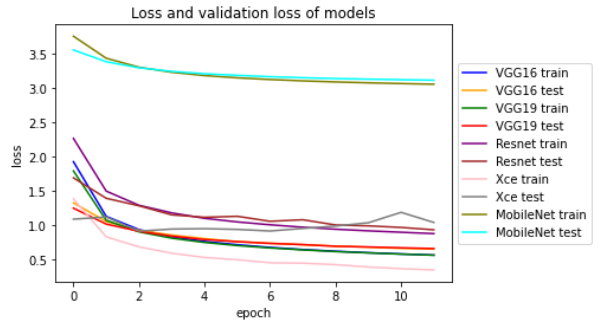
FIGURE XI. LOSS AND VALIDATION LOSS OF MODELS DATASET 3. Figure XI represent how loss (train) and validation loss (test) has changed during the 12 epochs, Xception, VGG16 and VGG19 shows a low loss for train and test. However, Xception shows a little high validation loss, compared to the one in dataset 1, as we note that the overfitting is shrink compared to the results we got in the sections before, and the longer the go stable they get, also we note that ResNet achieve a medium loss, while, MobileNet shows a bad result, where we see the loss (train) and validation loss (test) is